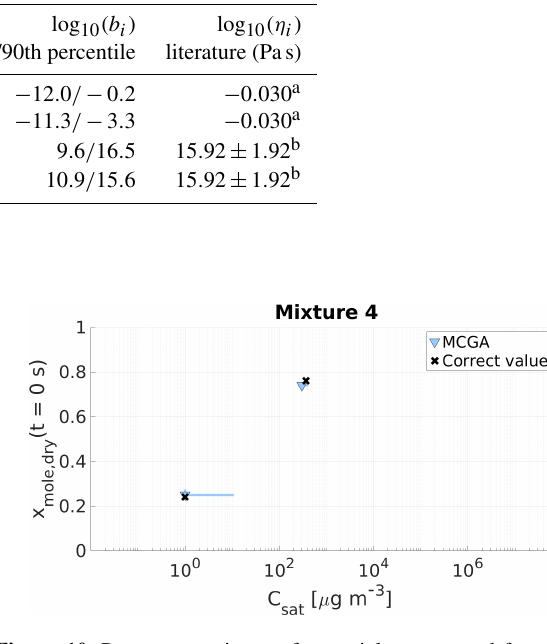
Figure 10. Parameter estimates for particles generated from mix- ture 4. Dry particle mole fraction at the start of the evaporation of two compounds and their saturation concentrations and the viscos- ity parameters b i were optimized to match the evaporation data. Light blue triangles show the MCGA estimates and black crosses show the literature values. The whiskers show the 10th and 90th percentiles of the estimated variable distributions. Sucrose C sat is marked at the lower limit of the C sat range due to its assumed low